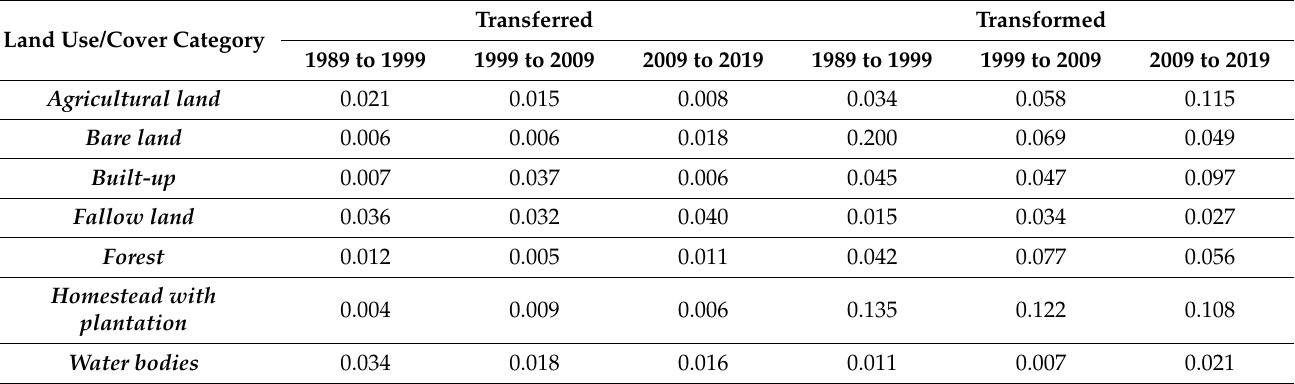
Table 17. Land use and land cover transferred index and transformed